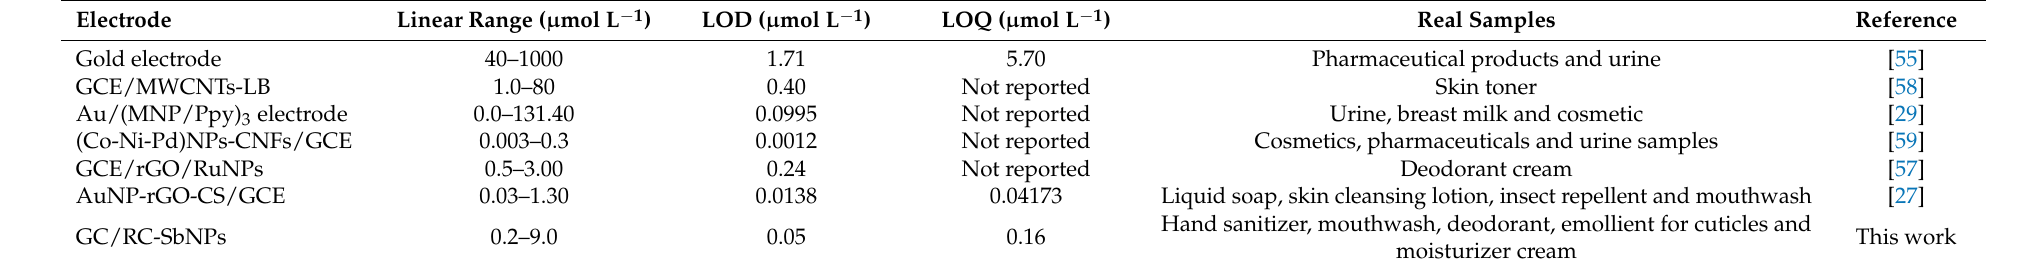
Table 1. Comparison of the reported values for LOD of